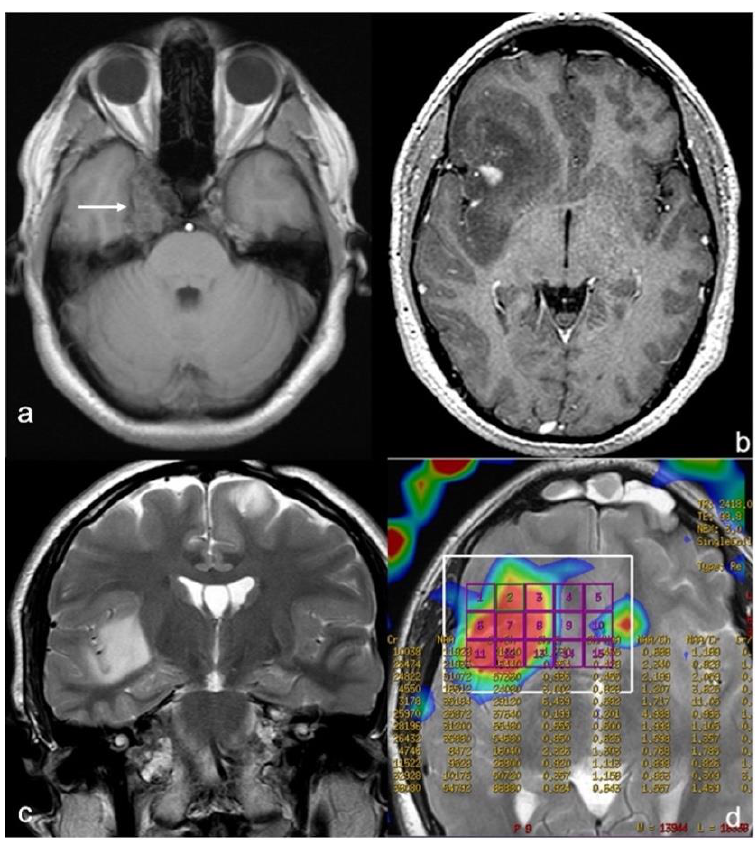
Figure 2. Brain MRI. ( a ) Axial T1 weighted sequence: bone lesion at right sphenoid wing with irregular borders to refer an enchondroma (with arrow). ( b ) Post-contrast axial T1-weighted sequence: multifocal bi-hemispheric lesion, with that one of maximum diameter and with contrast-enhancement at frontal-temporal-insular region of the right hemisphere. ( c ) Coronal T2 weighted sequence: multifocal lesion with right insular and left frontal involvement. ( d ) Perfusion axial sequence: increased cerebral blood flow at the lesion .